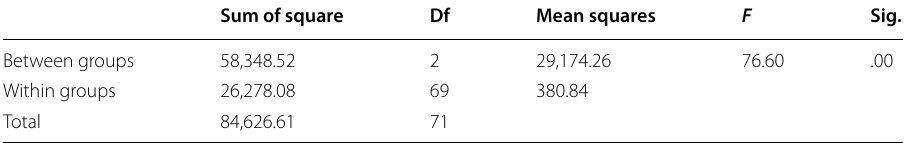
Table 9 Inferential statistics of the three groups on the self-regulation post-tests Sum of square Df Mean squares F Sig. Between groups 58,348.52 2 29,174.26 76.60 .00 Within groups 26,278.08 69 380.84 Total 84,626.61 71